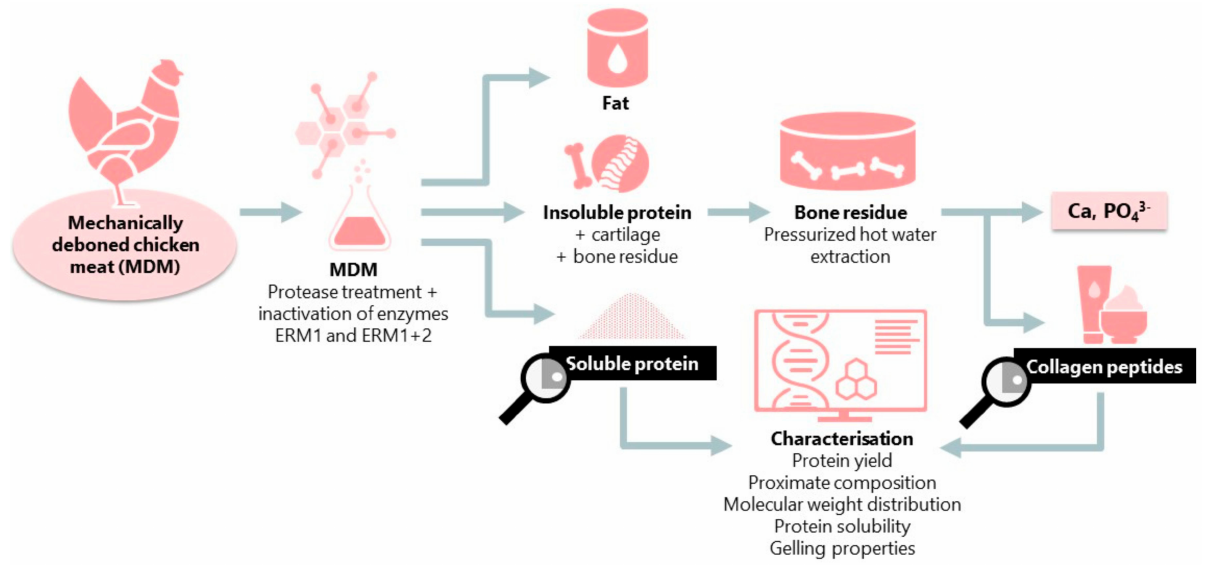
Figure 1. Chicken mechanically deboned meat processing flow chart to produce soluble protein and collagen